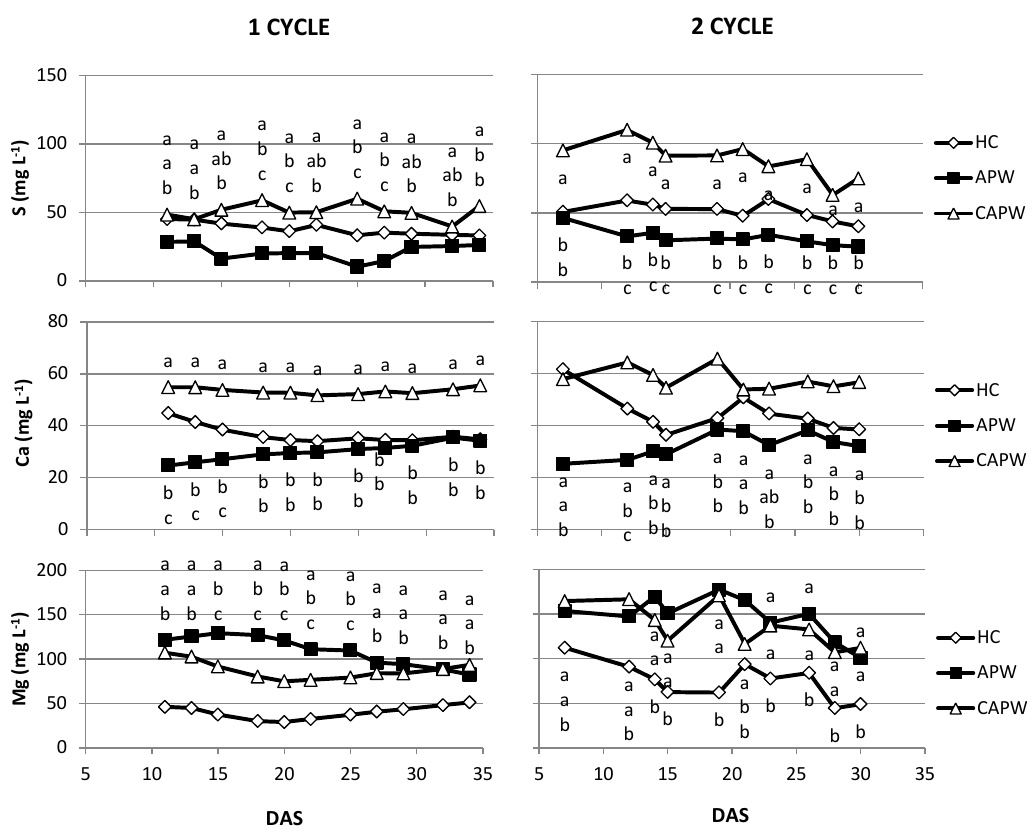
Figure 5. Effect of water treatment on sulphur, calcium, and magnesium concentrations during the growth cycles. Different letters on the same DAS indicate significant differences, with p < 0.05, based on Tukey HSD Test. HC: hydroponic control; APW: aquaponic water; CAPW: complemented aquaponic water.